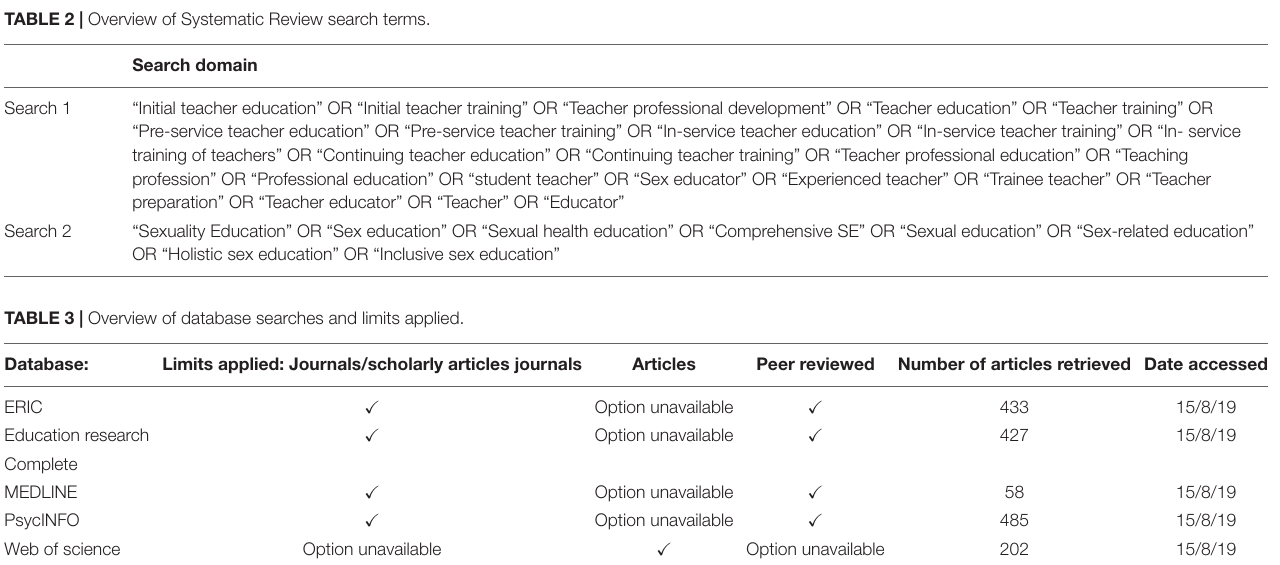
TABLE 2 | Overview of Systematic Review search terms.